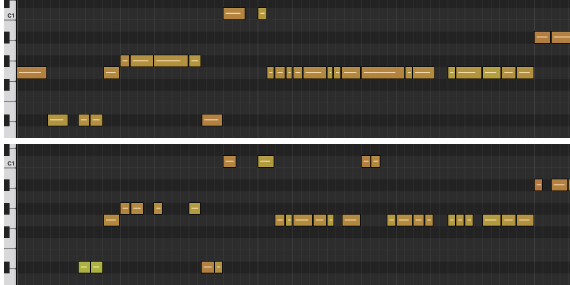
Figure 9. Pianoroll renderings of generated bass lines. See the text for